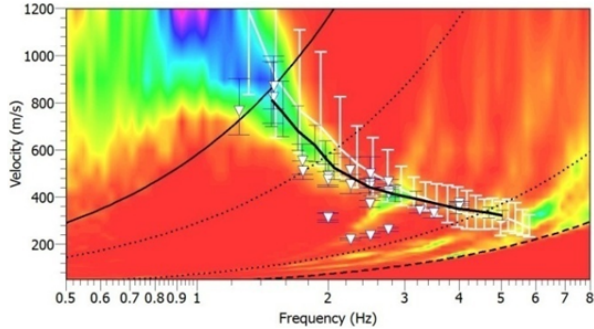
Figure 5. Dispersion curve of the array ARF. The black curve is the picked dispersion curve with relative error bars. The white curve is the dispersion curve obtained applying the MSPAC method to the same dataset. The white triangles are the phase velocities derived from the analysis of the coherent transient signals. The resolution curves are: k min : thick dashed line; k max : thick line; k min / 2 k max / 2 : dotted